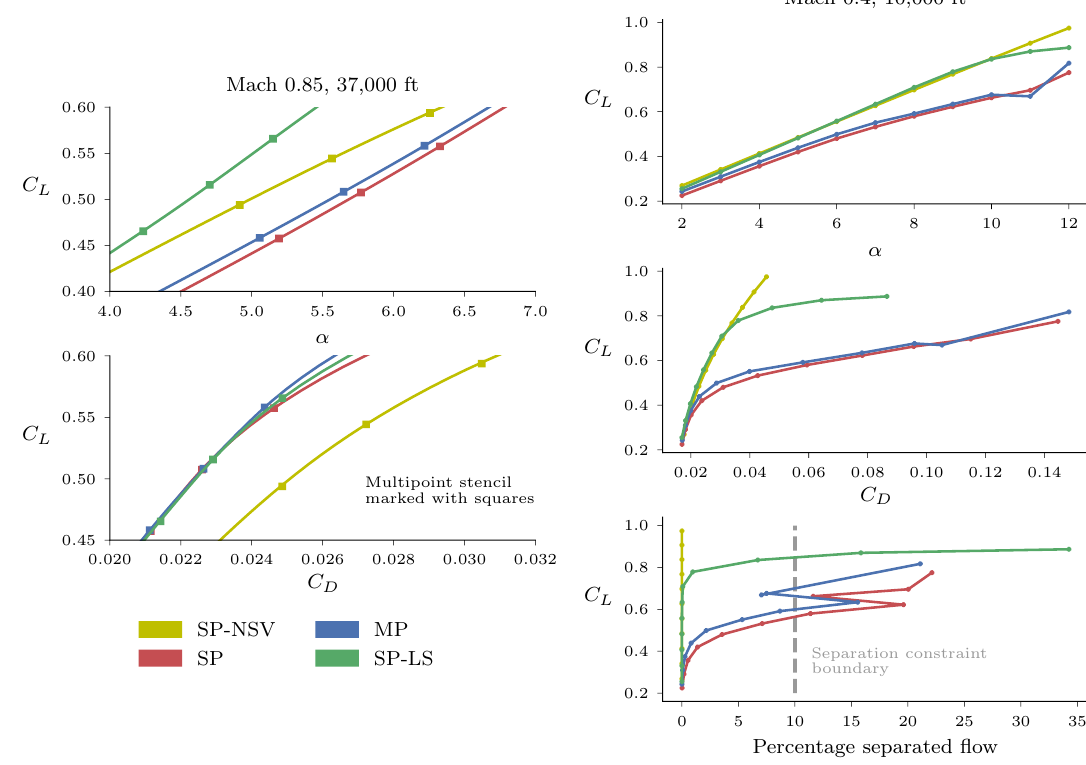
Figure 15. The low-speed separation constraint improves robustness at both cruise and climb flight